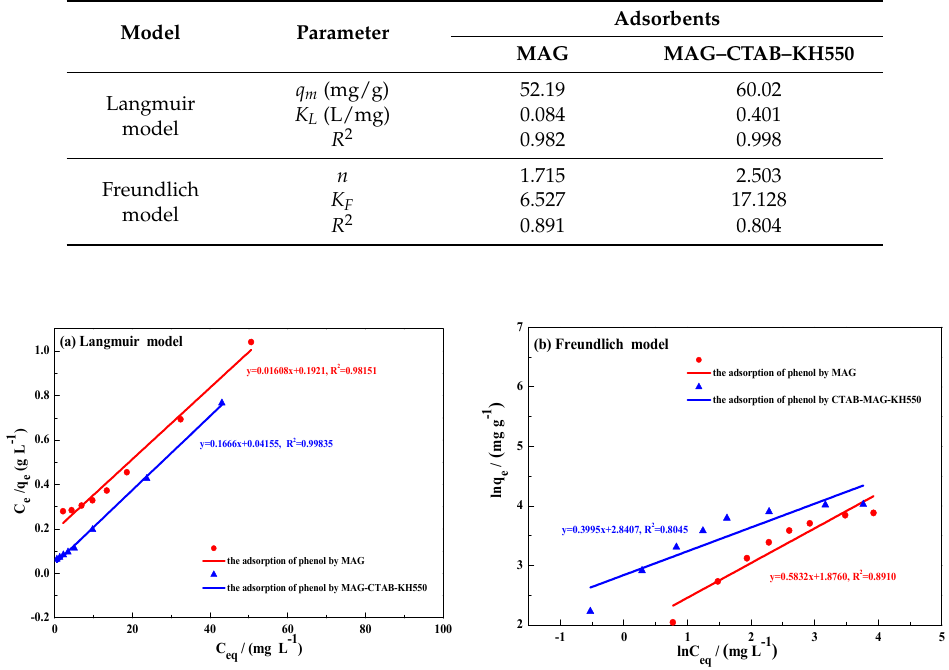
Table 4. Parameters of isotherm models of phenol adsorption by two adsorbents.